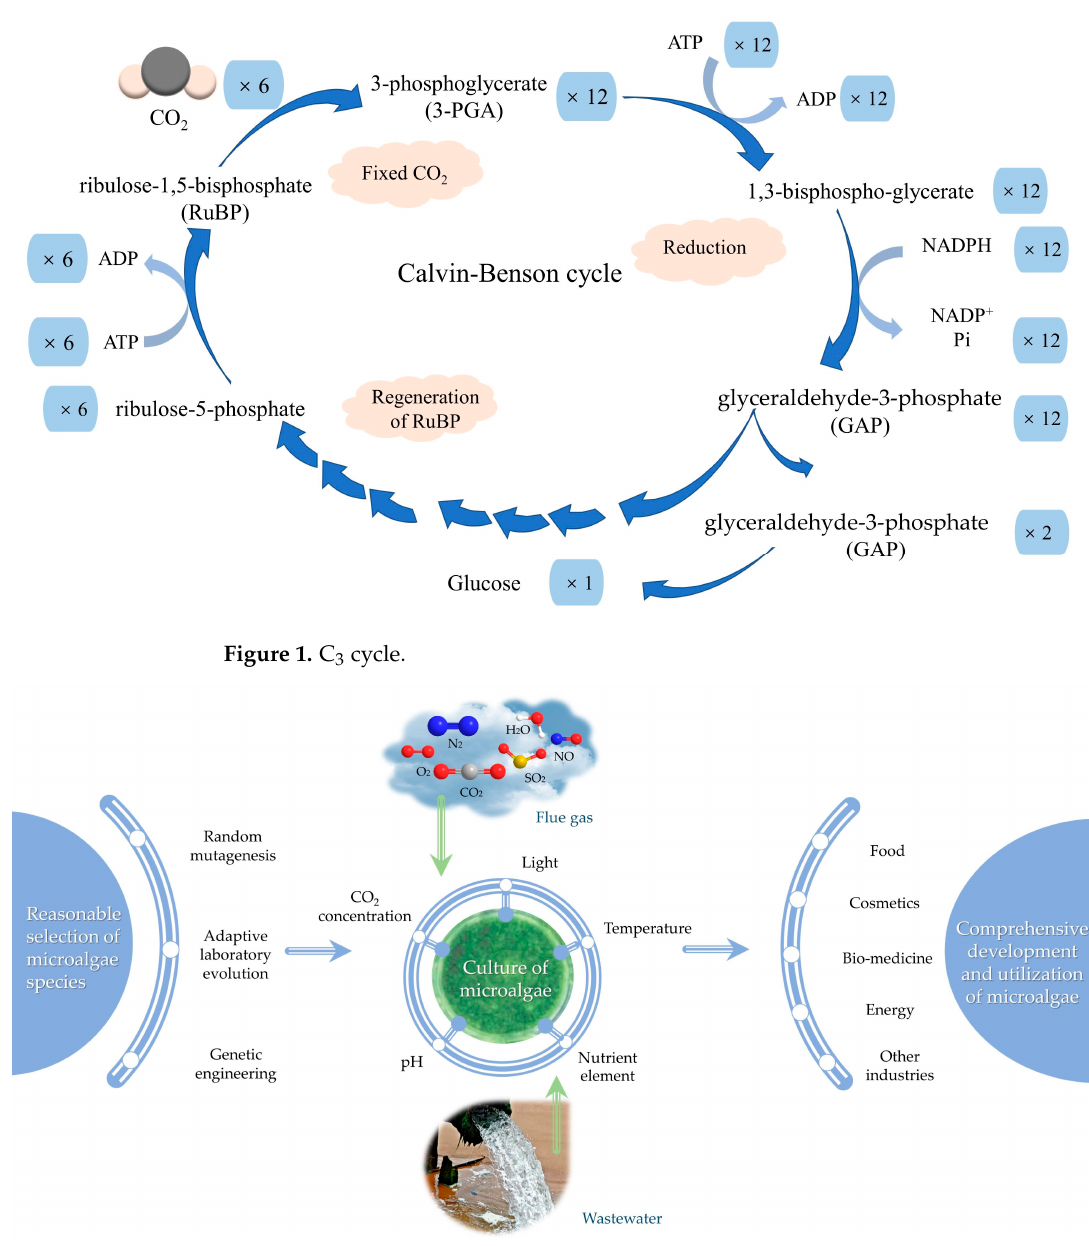
Figure 2. The technical flow chart of microalgae carbon sequestration.